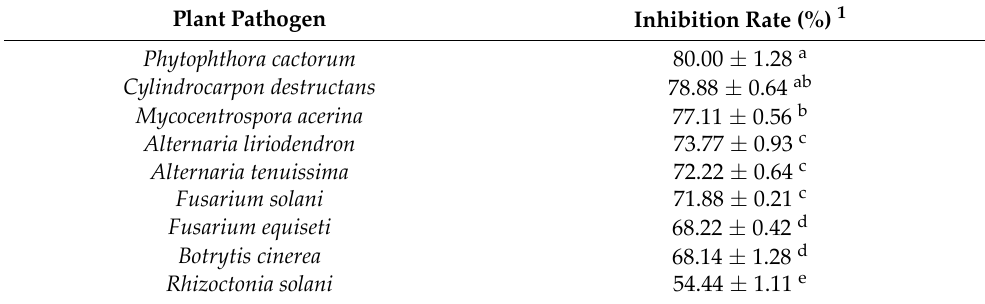
Table 2. Antibiotic activities of strain MR‑16 against fungal